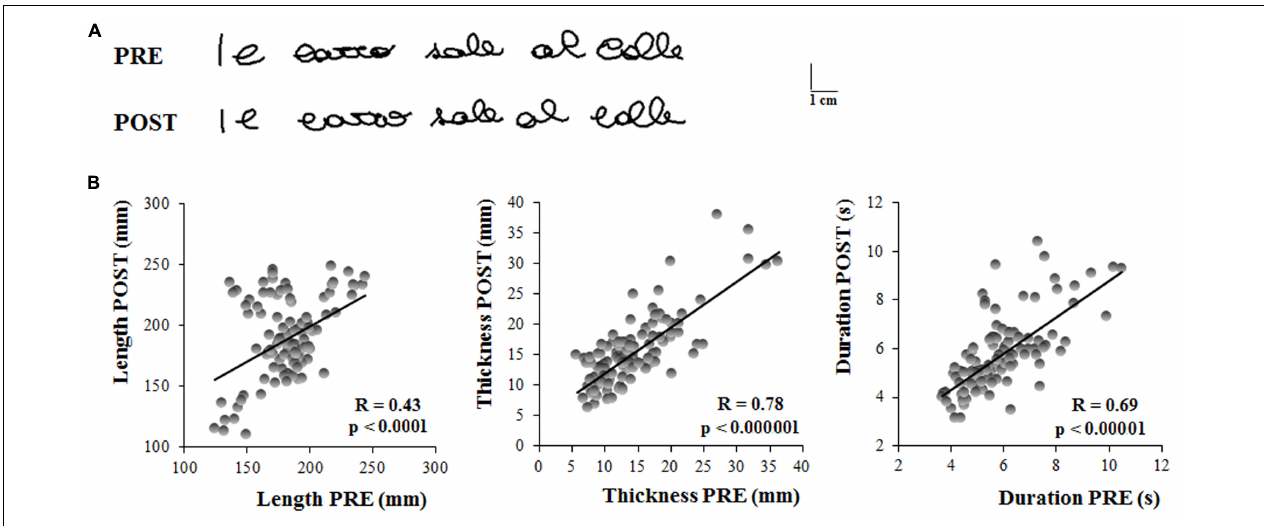
FIGURE 2 | Experiment 1. (A) Written traces of one representative participant acquired the in first testing session (PRE) and 1 month later (POST). (B) These graphs show the linear regression models that describe the relationship between the kinematic parameters of the sentences written by the subjects 1 month apart. Each dot refer to a single sentence written by a participant. Each participant wrote five sentences in each testing session. Pearson’s coefficient (R) and the related level of significance (p) are reported in each graph.